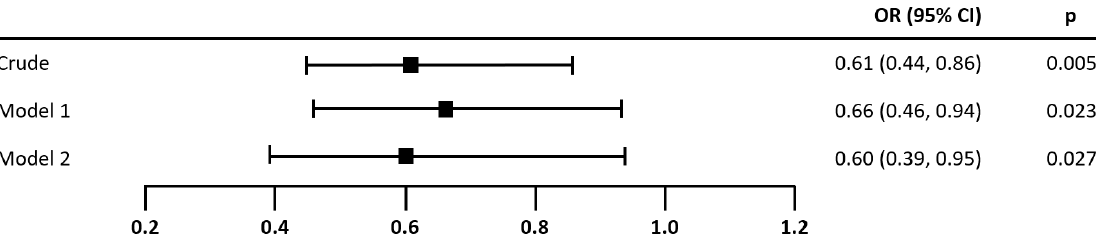
Figure 5. Association of HEI score with the presence of atrial fibrillation. Note. N = 104. Odds ratios (OR) for the presence of atrial fibrillation per 7.86 points increase in HEI. The maximum score of the HEI was scaled down from 110 to 14 for the logistic regression, in order to make the results comparable to MEDAS. Model 1 was adjusted for income, resting heart rate, log MET, energy intake, and diet change in the past year. Model 2 was additionally adjusted for log NT-proBNP. The odds ratio for log NT-proBNP in Model 2 was significant: OR (95% CI) = 36.71 (7.74–174.17), p < 0.001. Wellness of fit, correct predictions, and overall model-fit statistics—Crude: Nagelkerke’s R 2 = 0.112, 61.54%, Chi 2 = 9.15, p = 0.002, Model 1: Nagelkerke’s R 2 = 0.173, 63.46%, Chi 2 = 14.49, p = 0.043, Model 2: Nagelkerke’s R 2 = 0.476, 79.81%, Chi 2 = 45.92, p < 0.001.